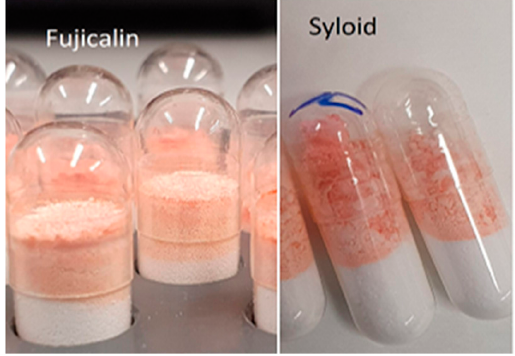
Figure 4. Inhomogeneous distribution of API solution (colored).